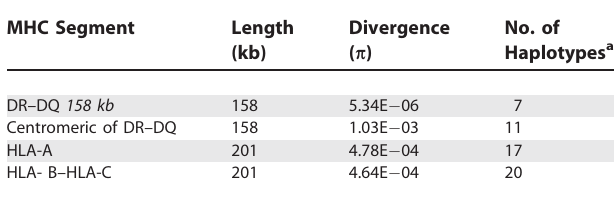
Table 3. Divergence Estimates for Different Regions in the MHC Observed on 26 Chromosomes Sharing the